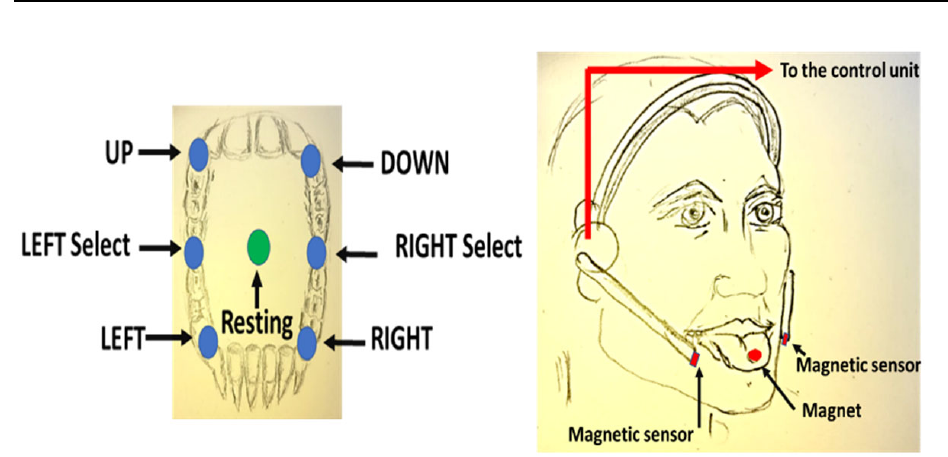
Figure 2. Sketch (realized by D.G.) of the first version of the TDS.